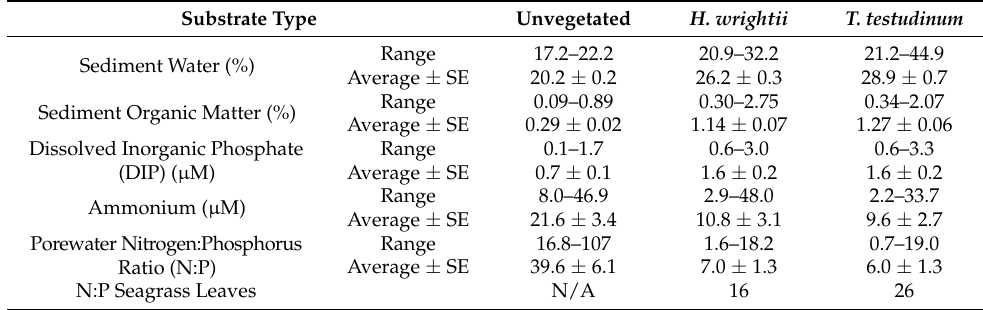
Table 1. Percent water, percent organic matter, and porewater nutrients in unvegetated sediments and H. wrightii and T. testudinum sediments. Leaf N:P ratios are from Atkinson and Smith